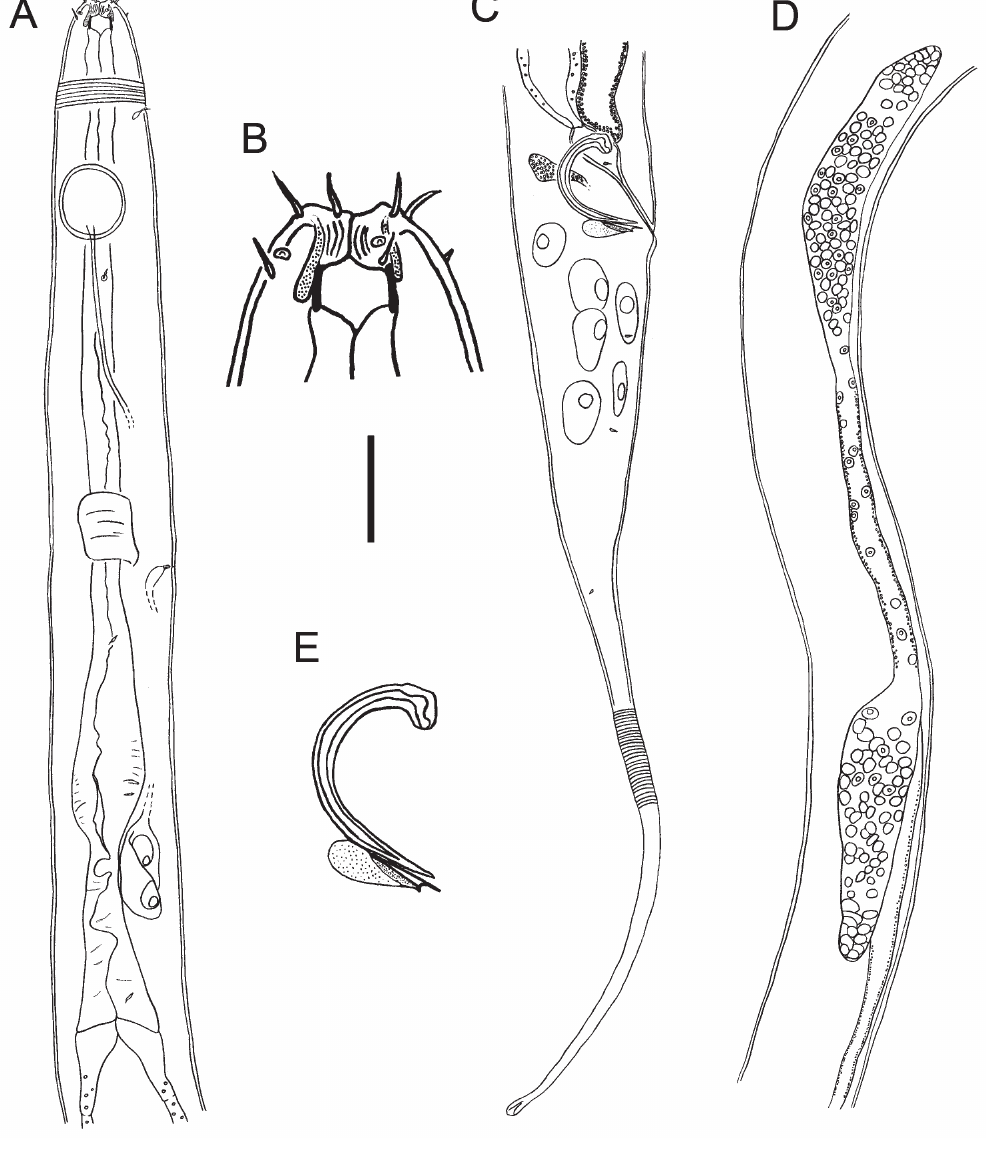
Fig. 1. Thelonema clarki sp. nov. Holotype, ♂. A . Anterior body region. B . Head, showing buccal cavity and cephalic sensillae. C . Posterior body region. D . Gonads, right-hand side view. E . Spicule and gubernaculum. Scale bar: A, c = 40 µm; B = 12 µm; D = 45 µm; e = 20